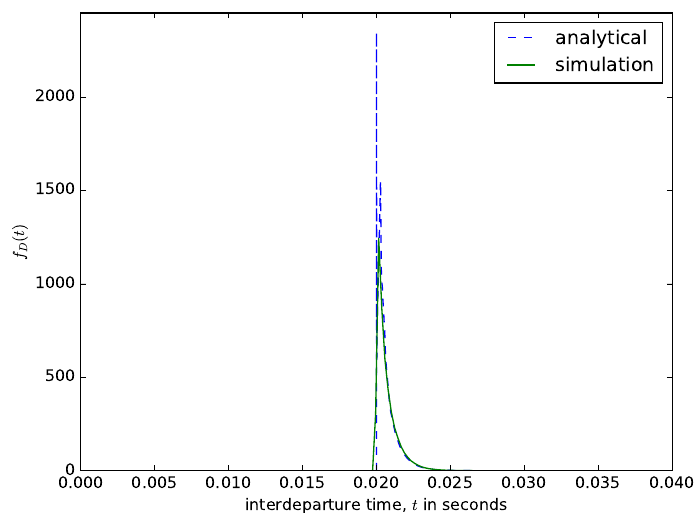
Figure 10. The distribution of the interdeparture times for a time-based packet aggregation